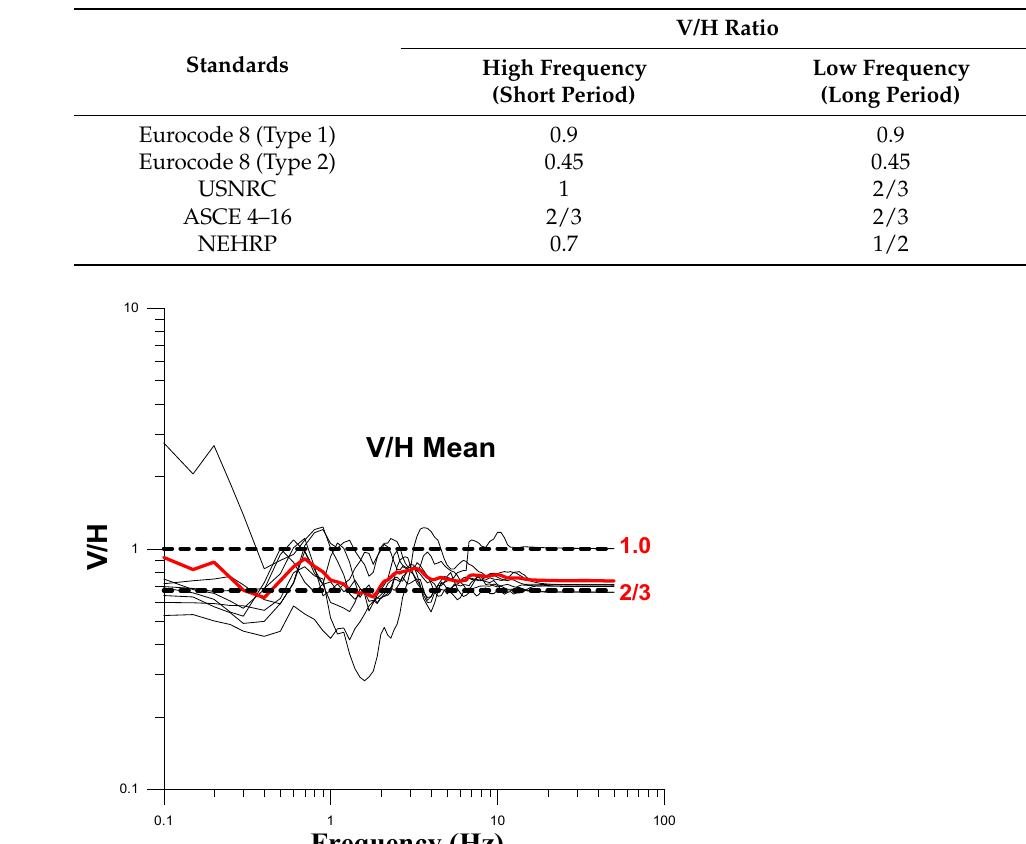
Table 3. The vertical-to-horizontal (V/H) ratios of seismic standards.